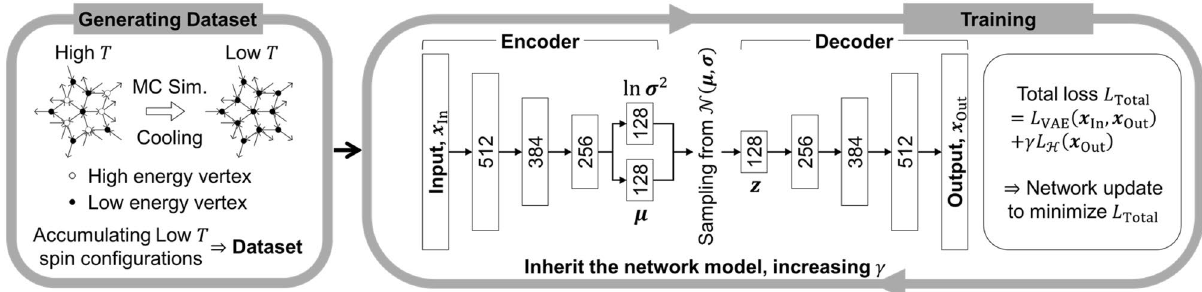
Figure 1. Deep learning process to search for the ground states of complex spin-ice systems. A schematic diagram for the dataset generation and the training process of E-VAE model used in this study. Simulated annealing implemented by a Monte-Carlo simulation (MC Sim.) is used to generate spin configuration datasets. Fully-connected neural network layers are used to implement the network structure, and the numbers indicate the hidden units of each layers. See “Methods” section for a detailed